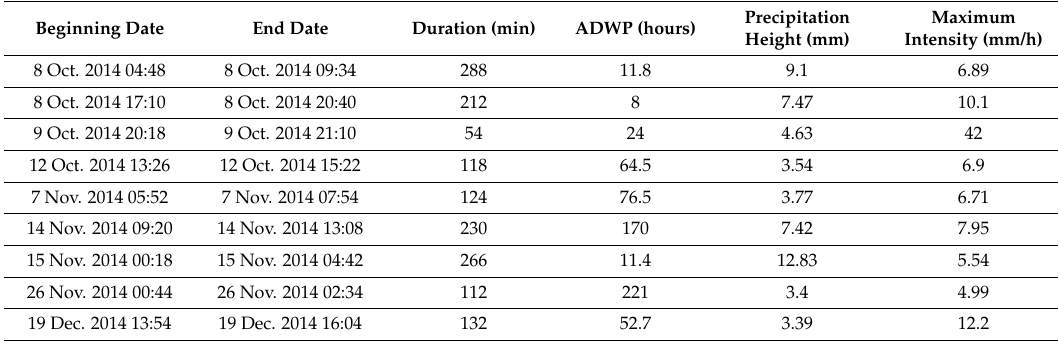
Table A2. Characteristics of the nine rainfall events for which water quality modeling results were exploited.